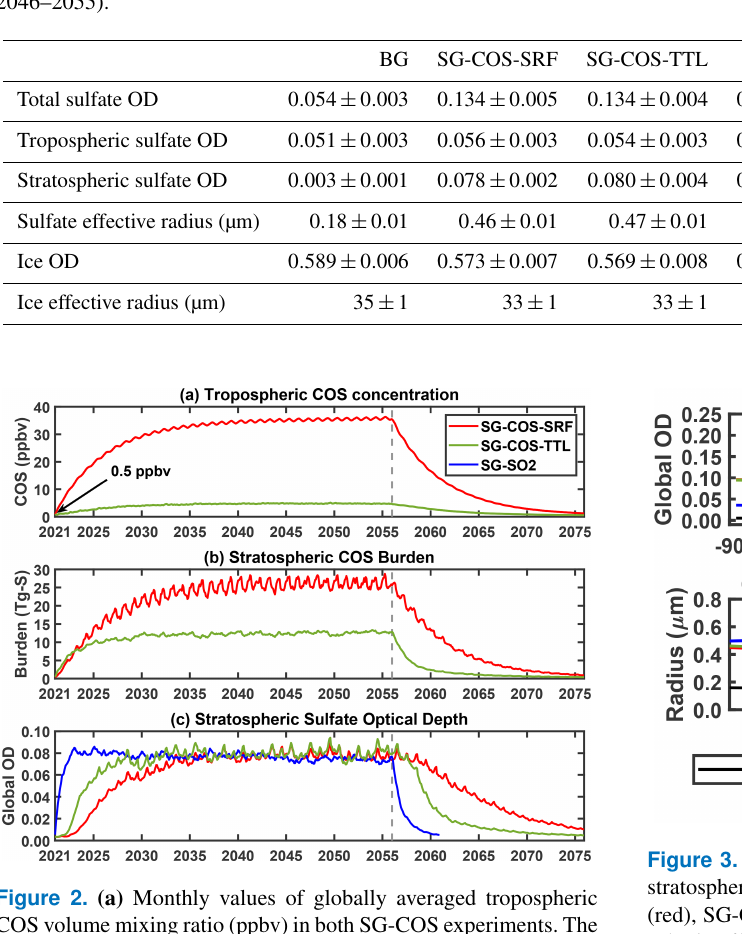
Table 1. Summary of the calculated sulfate aerosol and cirrus ice globally and annually averaged quantities relevant for RF calculations (i.e. optical depth at λ = 0 . 55µm and effective radius). The last two columns show the calculated SG changes with respect to the BG case (years